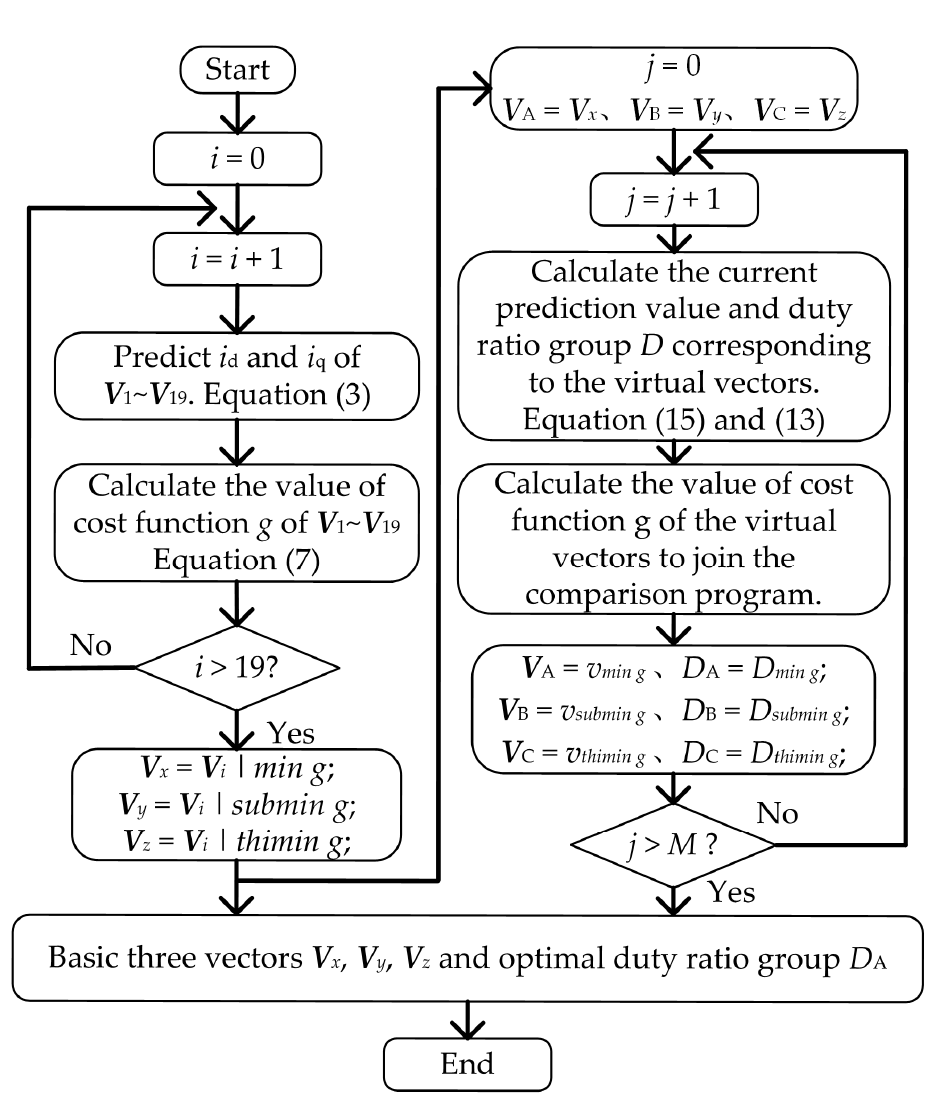
Figure 6. Flow chart of optimal vector search.